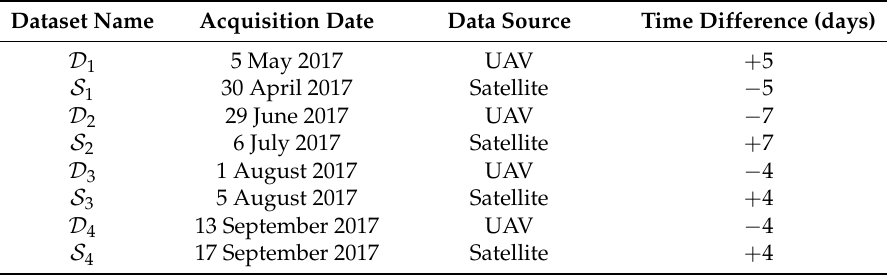
Table 2. Information on satellite and UAV based acquired